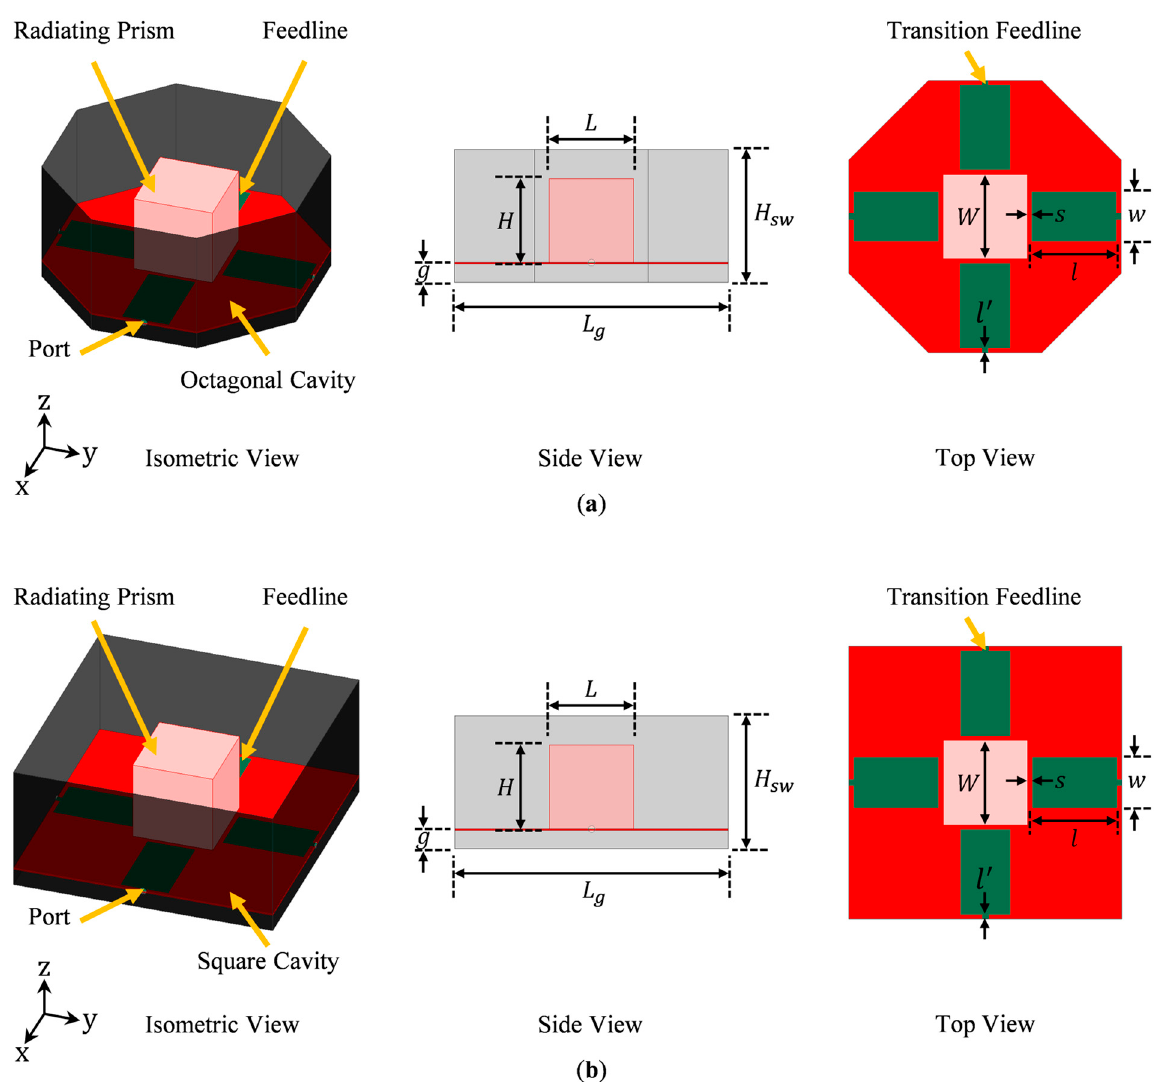
Figure 1. Geometries of cavity-backed radiating open prism antennas: ( a ) With an octagonal ground cavity; ( b ) With a conventional square ground cavity. ( conductive hollow open prism with no bottom face), supporting dielectric substrate, feedlines, conductive ground cavity).